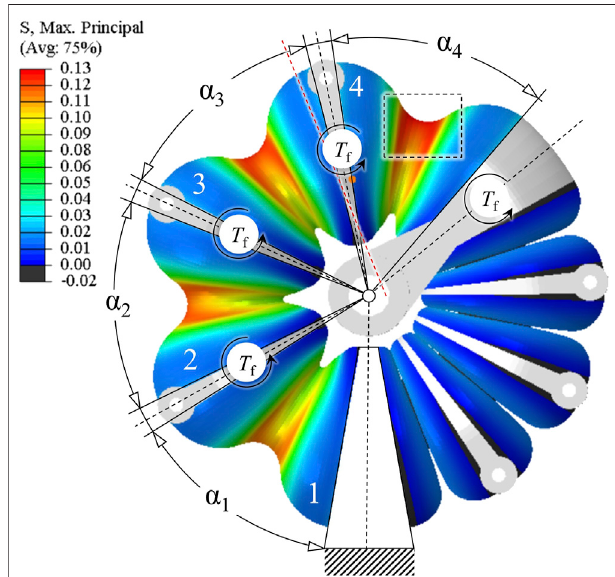
FIGURE 10 | FE model of a rotary bellows actuator. The drive shaft with the movable fl ange and the frames that connect the bellows segments are idealized to be completely rigid. The bellows segments are modeled as deformable solids with hyperviscoelastic properties. A pressure load was applied to all inner surfaces of the left bellows chamber, and torques T f were applied to fl anges and drive shaft to account for frictional effects. Evaluation of the maximum principal stress suggests that structural failure is most likely to occur at the inner diameter of the fourth bellows segment (dashed rectangle).